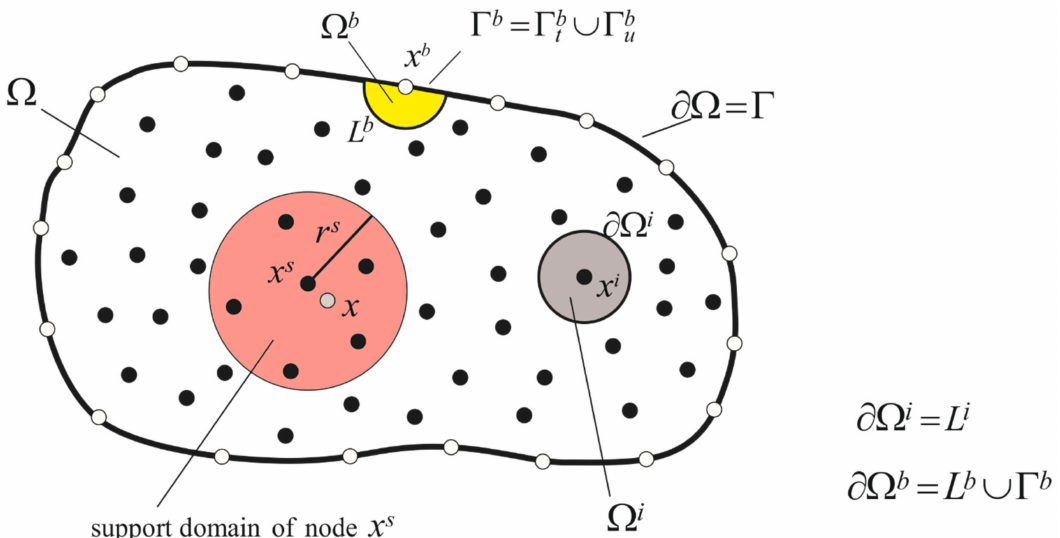
Figure 1. Local subdomains Ω i and Ω b with their boundaries for moving least-squares (MLS) approximation of the trial function; support domain of weight function around node x s